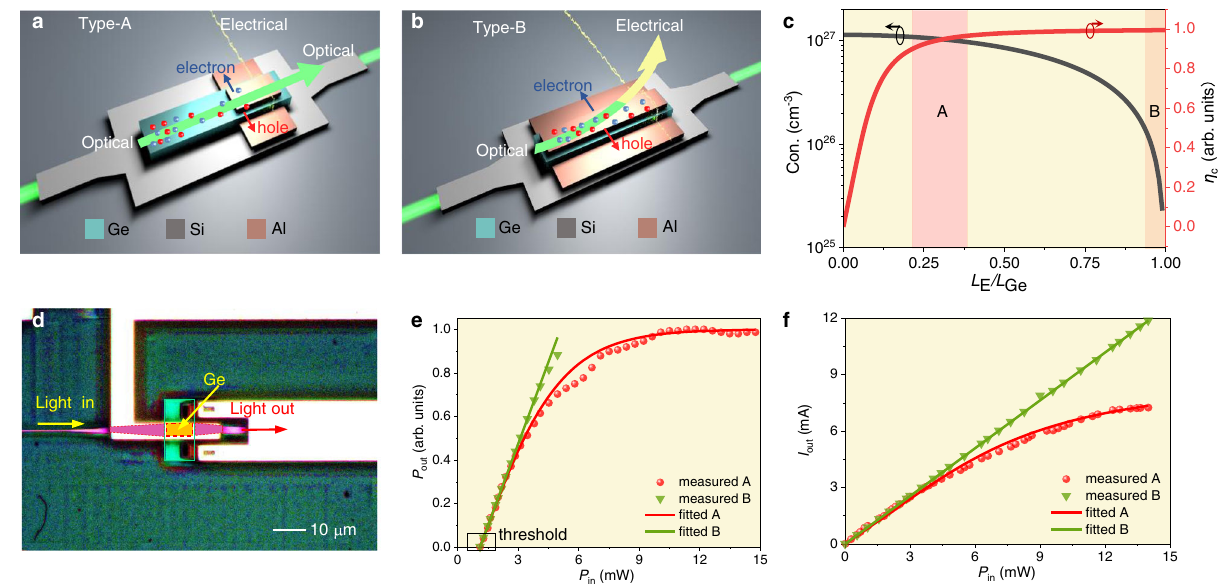
Fig.2|TheoreticalandexperimentalanalysisoftheGe-SiAONU.a Thestructure and schematic of the proposed AONU (Type-A). A large number of carriers are accumulatedinthenon-electrodepartoftheGe fi lm,whichenhancesthenonlinear interactionwithlight.Atthetailend,thecarriermovementformsthephotocurrent thatservedasa monitoring signal. The yellow wave ray represents the data fl ow of the electrical monitoring signals. b The structure of the conventional Ge-Si PDs (Type-B). c The carrier concentration and collection ef fi ciency versus length ratio. Con., concentration. d The false-color image of the AONU. Pink region, Si wave- guide.Yellowregion,Ge fi lm.Greenregion,SislabunderGe fi lm.Redregion,metal